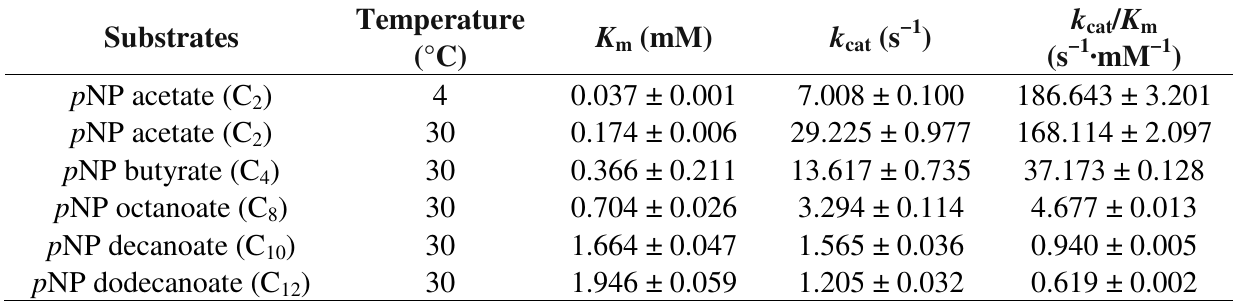
Table 5. Kinetic parameters for r-LipA on p-nitrophenyl